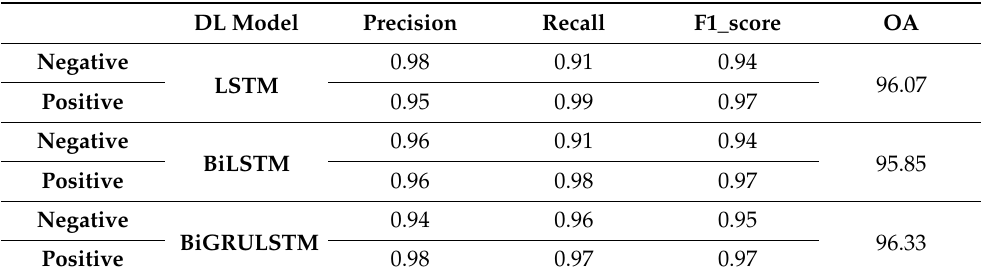
Table 2 . Performance metrics-( a ) LSTM; ( b ) Bi-LSTM; and ( c ) Bi-GRU-LSTM-CNN model.